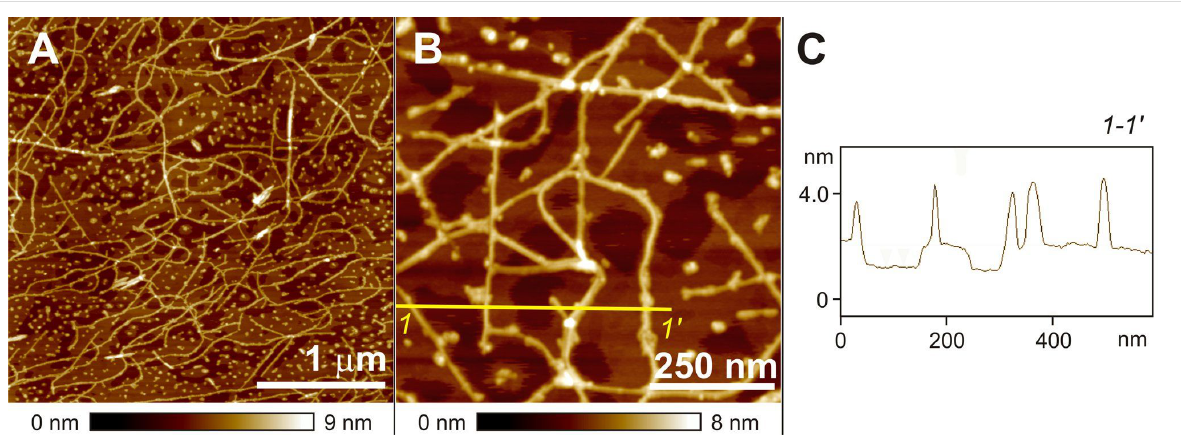
Figure 4: AFM height images (A and B) of a film spin-coated from MCH solution (concentration 5 x 10 − 4 M) of a 1:1 mixture of T1 and PCBM onto HOPG. The z scale (9 nm and 8 nm, respectively) is shown under the respective image. Figure 4C depicts cross-section analysis along the yellow line 1-1' in image B.